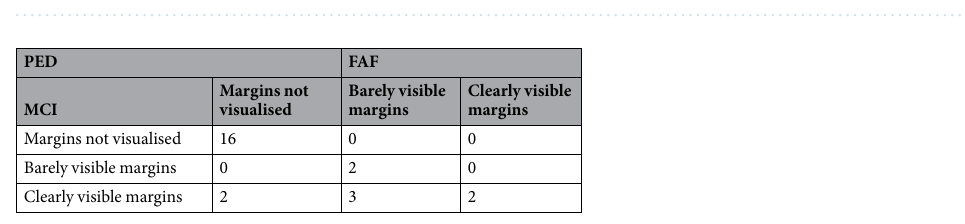
Table 3. Comparison of definition (distinctness) of retinal pigment epithelium (RPE) atrophy on multicolour imaging (MCI) and fundus autofluorecence (FAF). In 18/25 (72%) eyes, the grading was consistent while in seven eyes there was a discrepancy with six eyes favouring MCI.